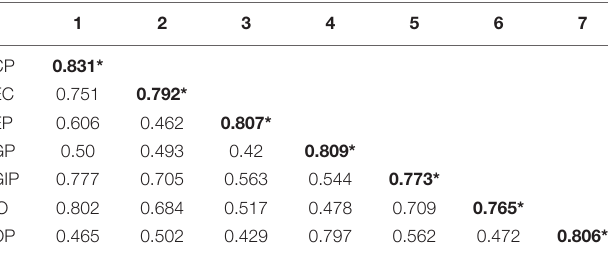
TABLE 3 | Discriminant validity coefficients.